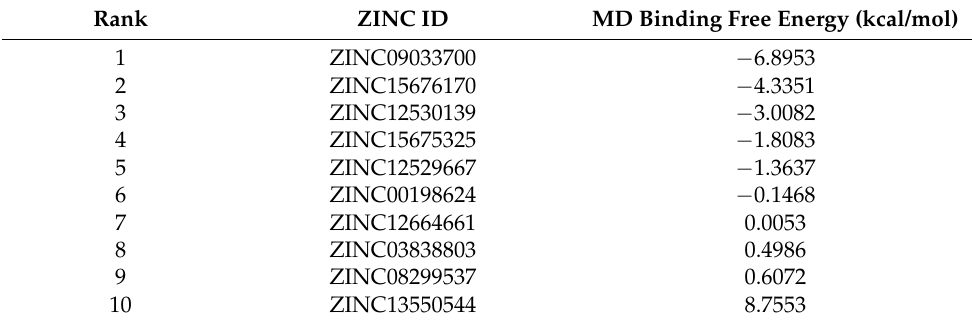
Table 2. MD binding free energy ranking of top 10 ligands with the highest docking